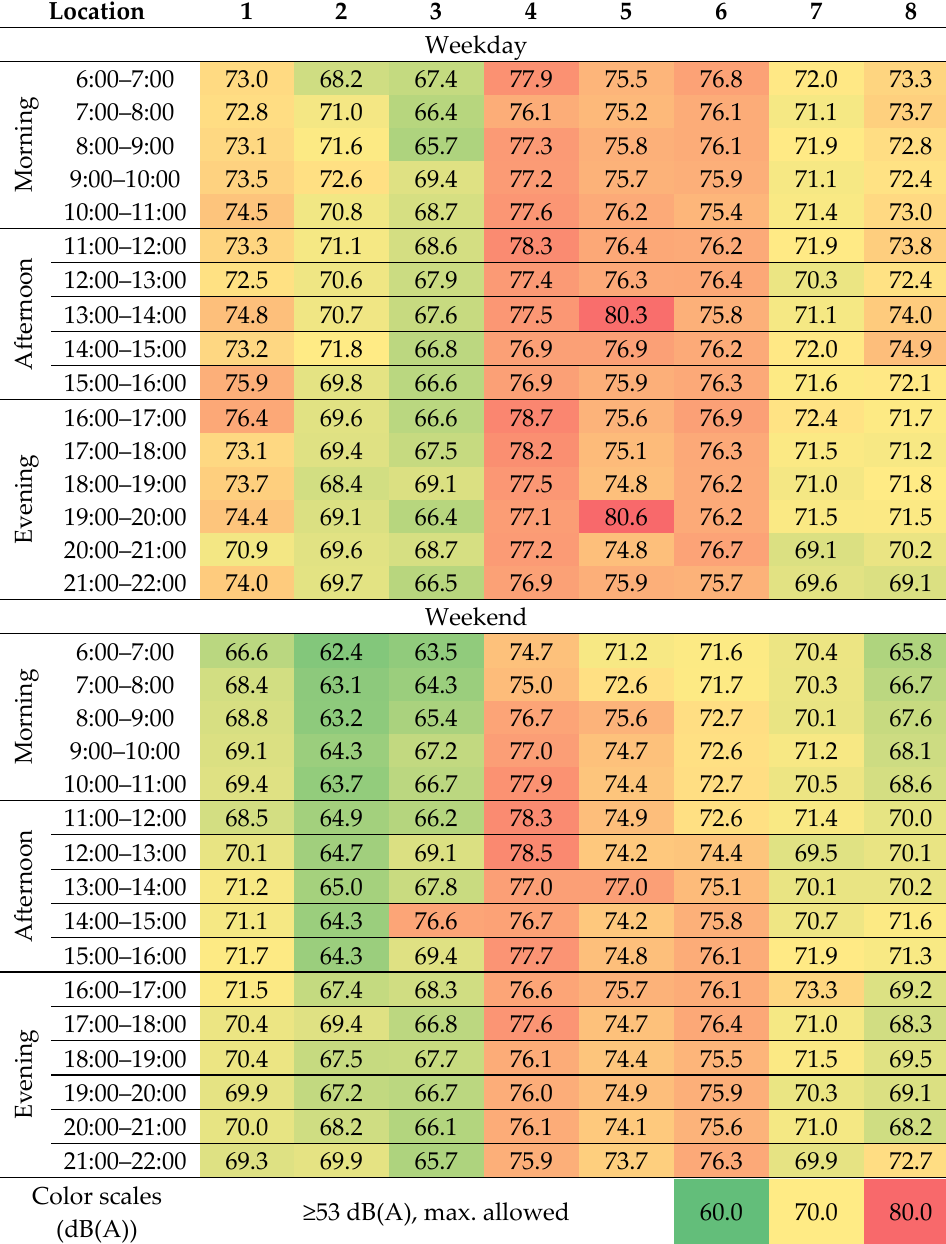
higher values above 70 dB(A), and shades of red color indicated that values were close to 80 dB(A). Table 6. Weekday and weekend hourly noise levels, L AFeq . 1h ., dB(A). Table 6. Weekday and weekend hourly noise levels, L AFeq . 1h .,